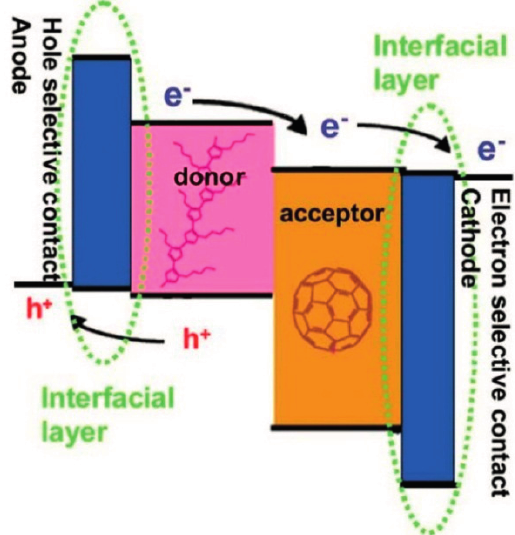
Figure 1. Schematic illustration of a polymer solar cell in extraction mode. Excitons are generated and diffuse to the donor/acceptor (bulk heterojunction) interface where the excitons dissociate to free charge carriers. The charge carriers are then transported to the electrodes and are extracted by the interfacial layers to the respective electrodes. Reprinted with permission from [36]. Copyright 2010 Royal Society of